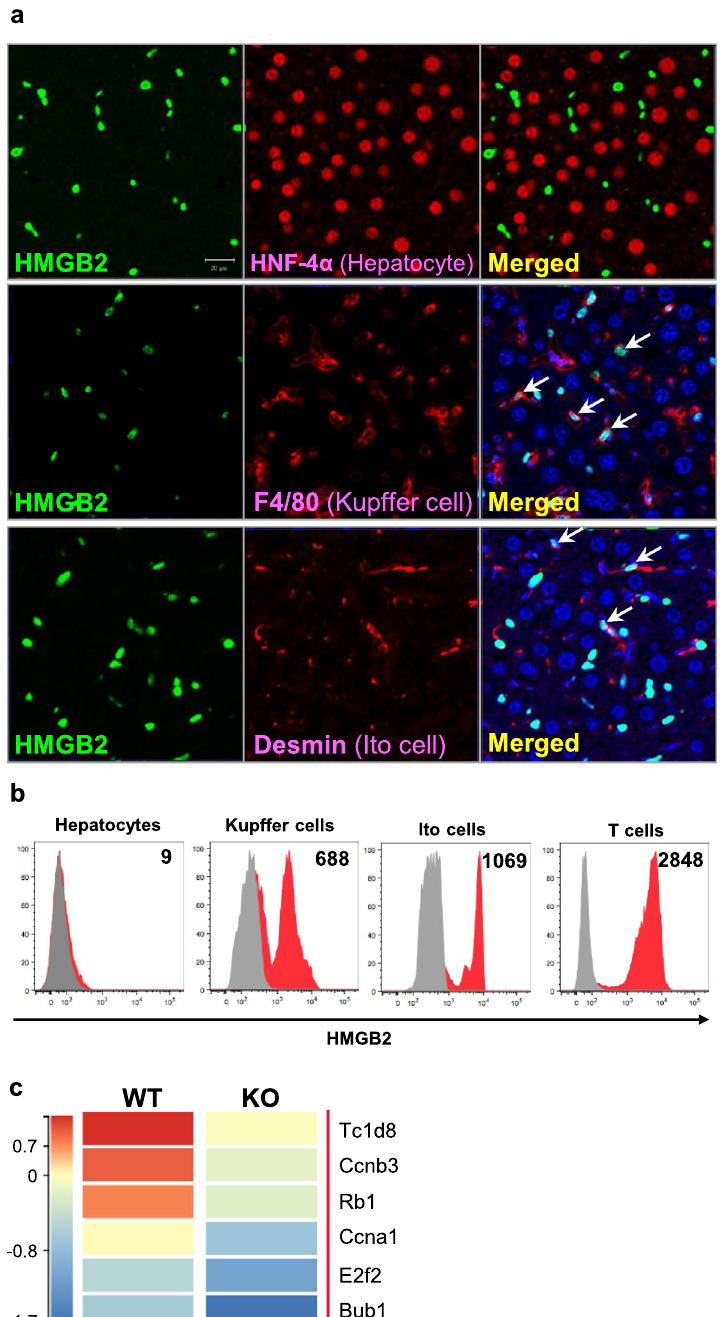
Figure 1. Expression of HMGB2 in mouse liver. ( a ) Double immunofluorescence for HMGB2 (green) and HNF-4α (red staining in upper panel), F4/80 (red staining in middle panel) and desmin (red staining in lower panel), DAPI (blue) in WT mouse liver. Scale bar 20 μm. ( b ) The expressions of HMGB2 and HNF-4α on hepatocytes (CD45-HNF4α + cells) or non-parenchymal liver cells (CD45 + CD3 + T cells, CD45 + , F4/80 + Kupffer cells, CD45-desmin + Ito cells) obtained from WT mice were analyzed by flow cytometry. Gray color indicates unstained cells, whereas, red color indicates double positive cells of HMGB2 and HNF-4α, F4/80, Desmin, CD3. Data are presented by a histogram, and numbers represent mean fluorescence intensity (MFI). ( c ) Heatmap of intact WT and HMGB2-KO mouse livers. Microarray results were analyzed in Transcriptome Analysis Console software (Version 4.0.2.15, Thermo Fisher Scientific) https:// www. therm ofish er. com/ jp/ en/ home/ global/ forms/ life- scien ce/ downl oad- tac- softw are.